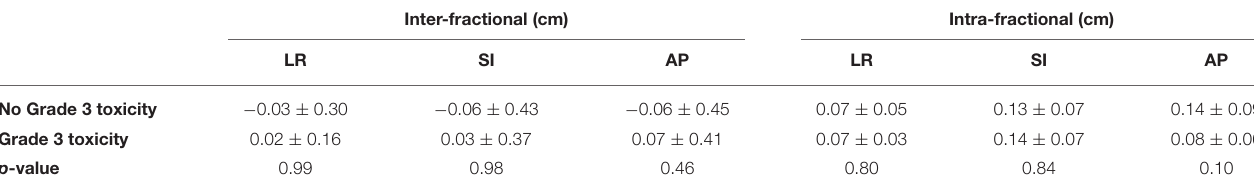
TABLE 3 | Mean inter- and intra-fractional prostate displacement (in cm) for patients with vs. without development of severe toxicity. Inter-fractional (cm) Intra-fractional (cm) LR SI AP LR SI